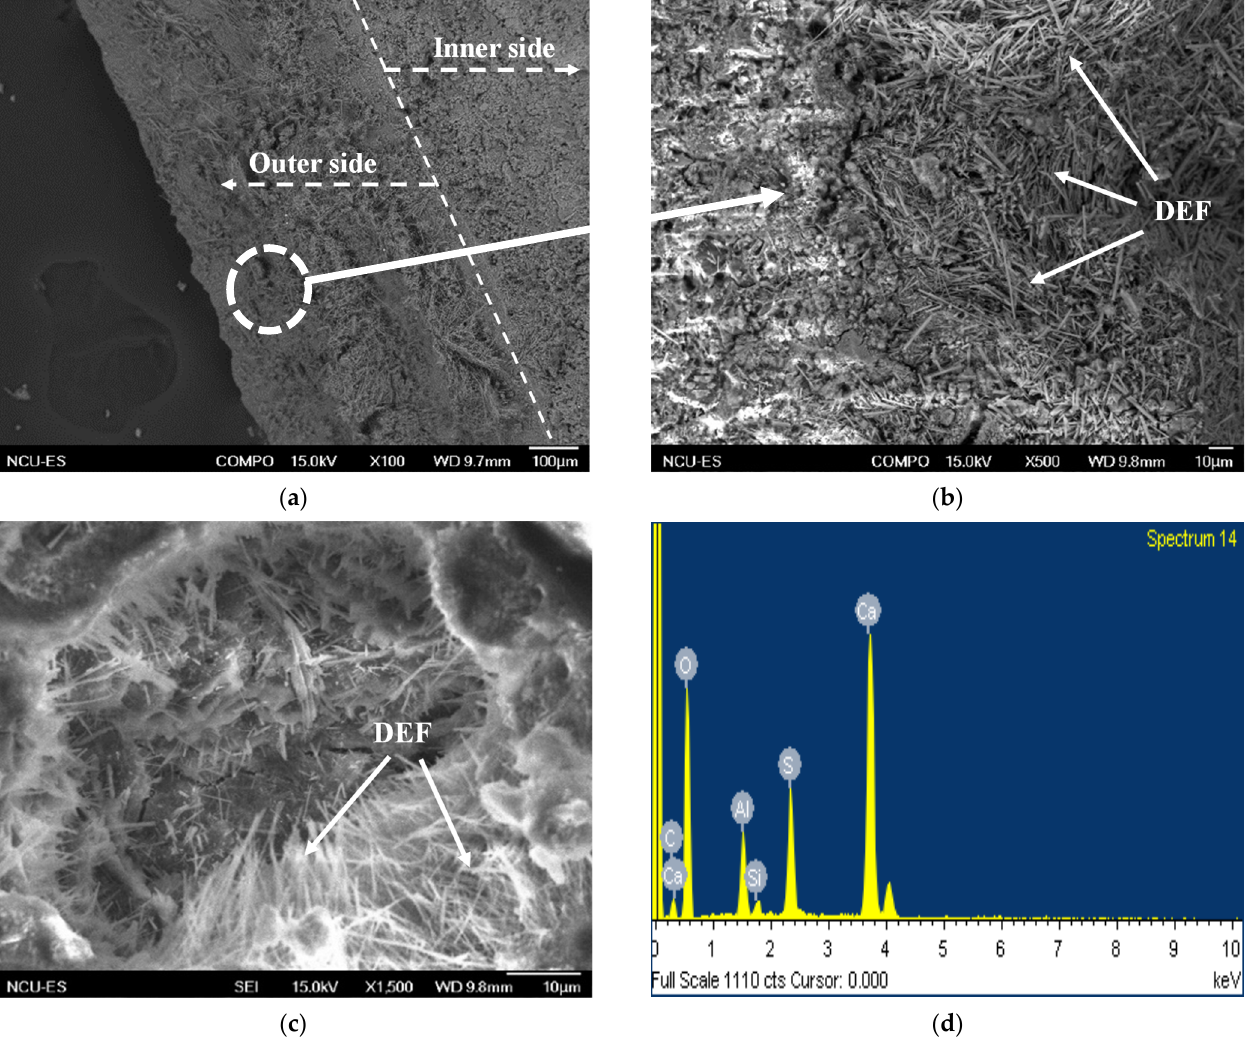
Figure 9. SEM micrograph of CFB fly ash-BFS blended paste under internal sulfate attack at 180 days. ( a ) SEM micrograph of ISA products. ( b ) ISA products (DEF) observed on the outer part. ( c ) ISA products (DEF) observed on the inner part. ( d ) EDX spectrum of the DEF.